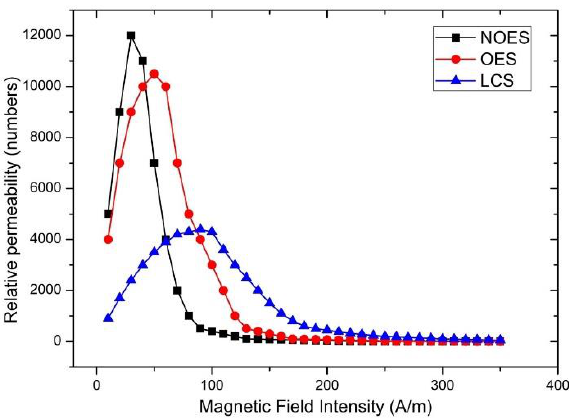
Figure 7. The permeability dependence of three sheets of steel on the excitation field.